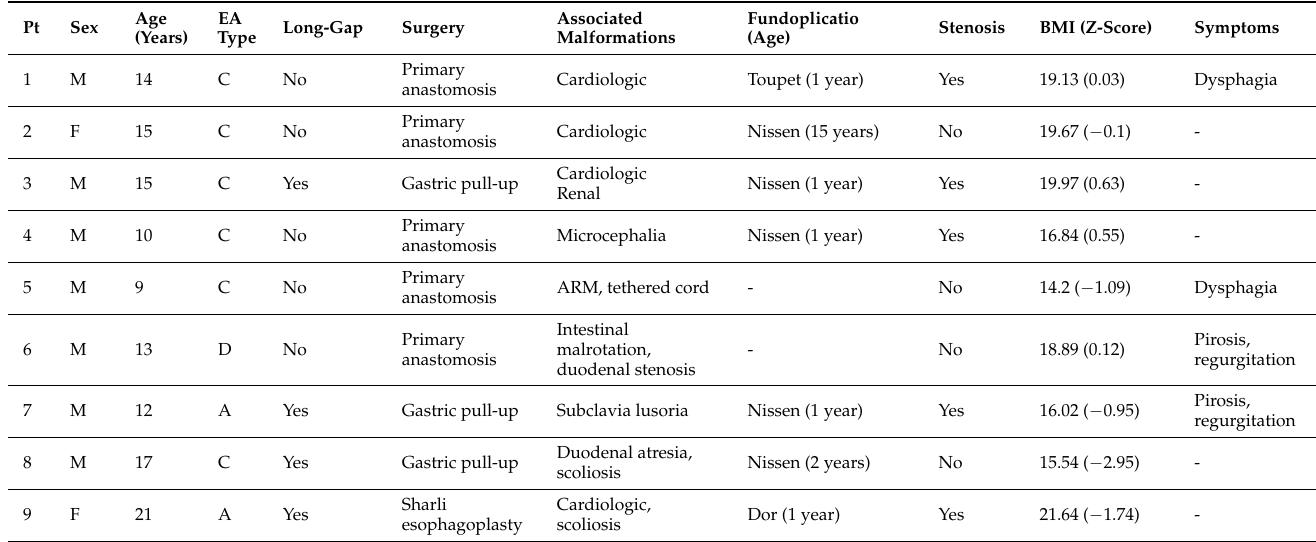
Table 2. Clinical data of esophageal atresia patients considered in the current